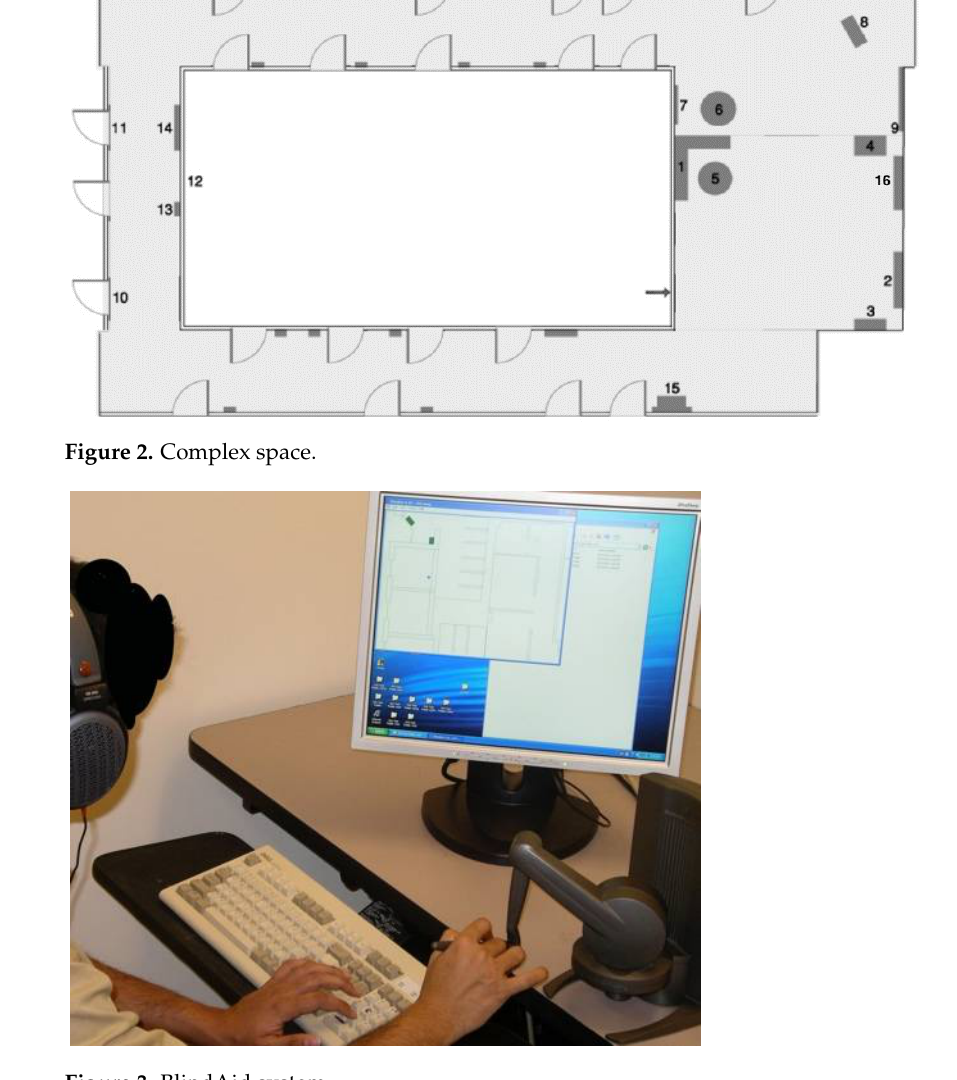
Figure 2. Complex space.